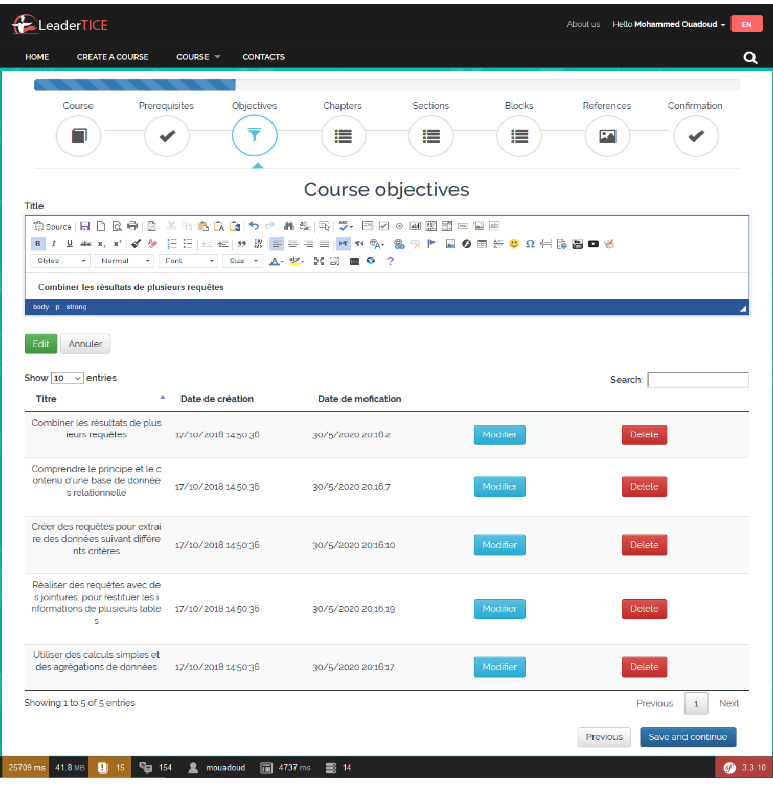
Fig. 5. Course objectives interface developed by the NoSQL MongoDB